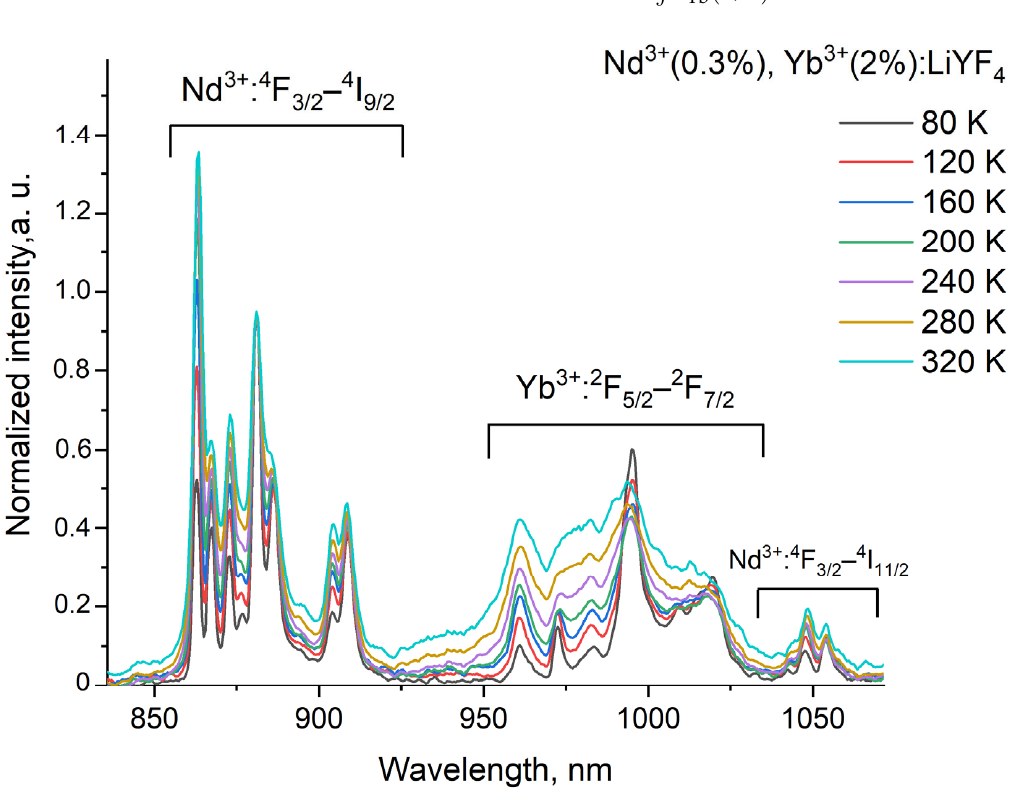
Figure 6. The normalized at 881 nm Nd 3+ (0.3%), Yb 3+ (2.0%):LiYF 4 luminescence spectra recorded in the 80–320 K range. The excitation λ ex = 520 nm corresponds to 4 I 9/2 – 2 K 13/2 / 2 G 9/2 absorption band of Nd 3+ .